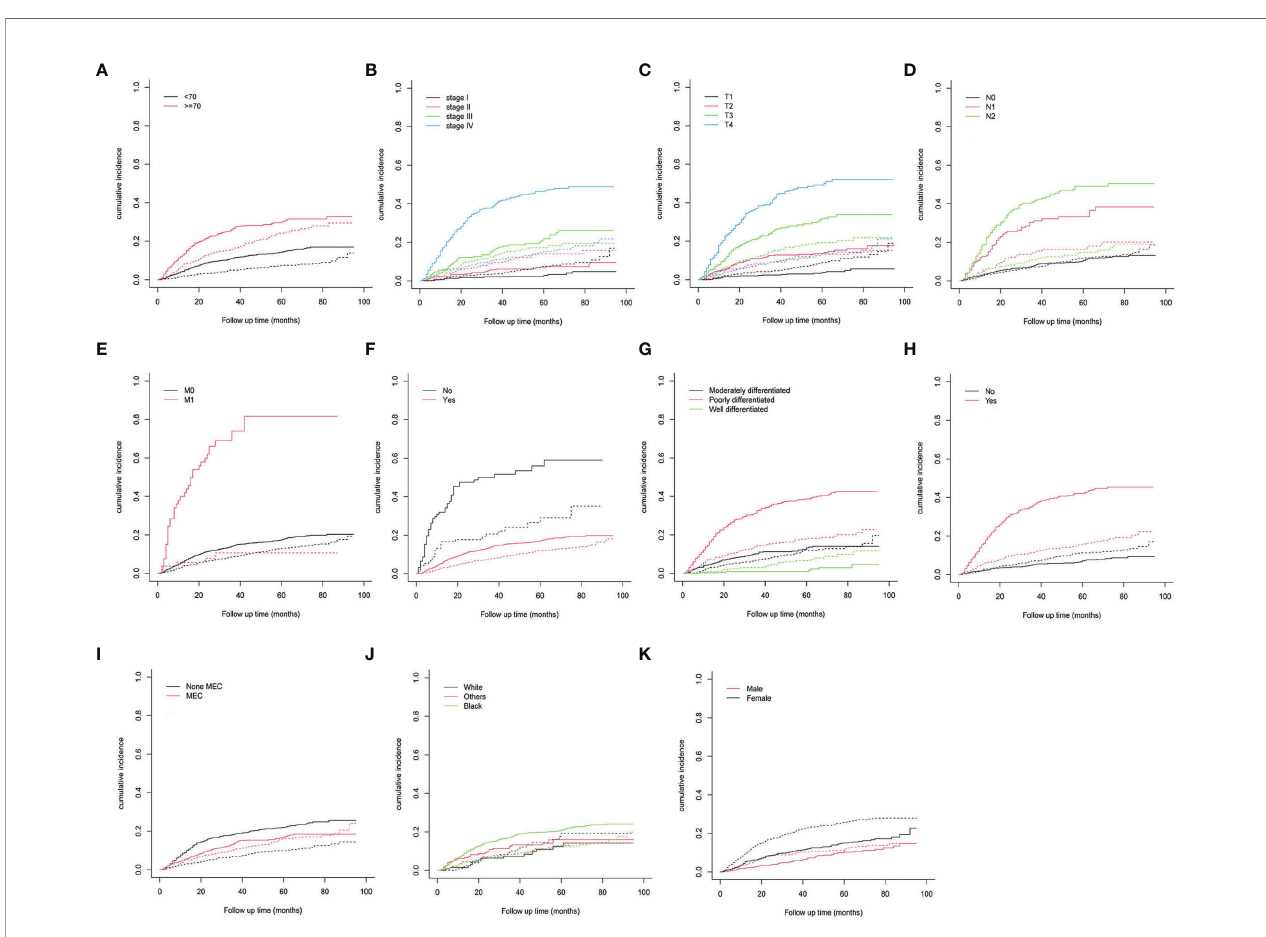
FIGURE 2 | Cumulative incidence predictions of CSD in parotid carcinoma. (A) Age; (B) AJCC stage; (C) T stage; (D) N stage; (E) M stage; (F) surgery; (G) grade; (H) radiation; (I) histologic type; (J) race; (K) sex. Solid line designates CSD; dotted line designates other causes of death. AJCC, American Joint Committee on Cancer; MEC, mucoepidermoid